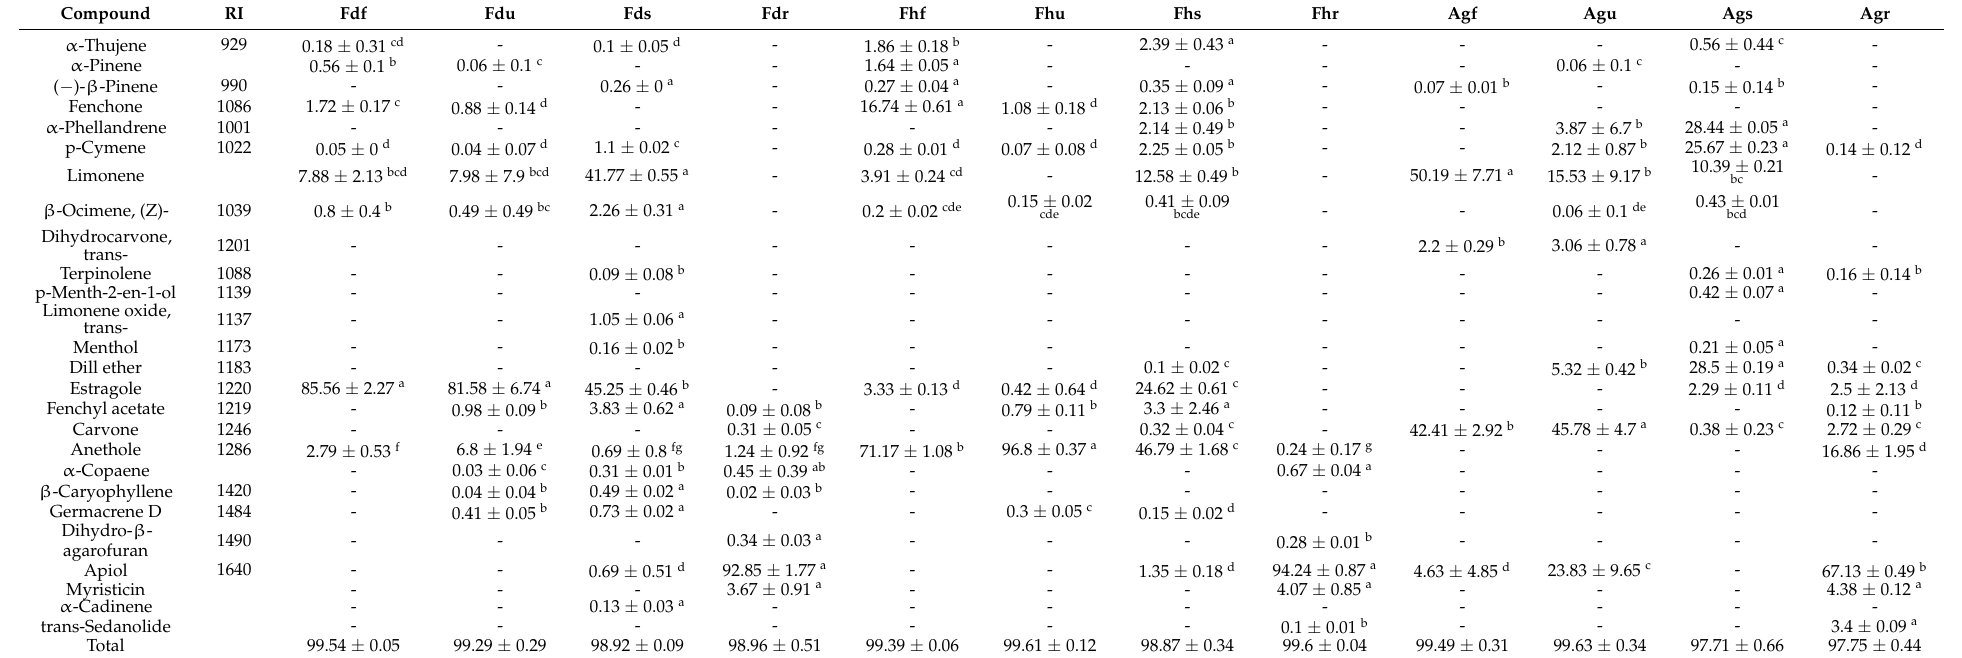
Table 1. Chemical compositions of essential oils derived from different parts of fennel and